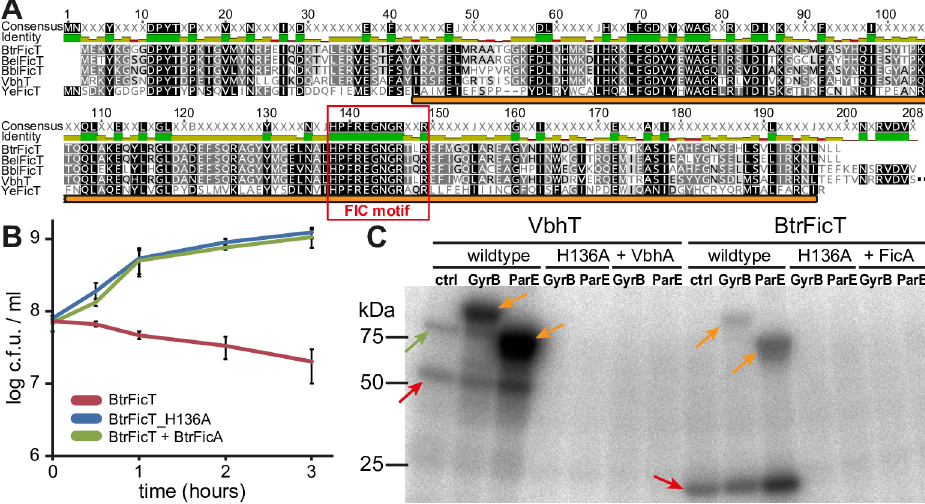
Fig 1. BtrFicTA is a regular FicTA module closely related to VbhTA. (A) Sequencealignment of YeFicT (UniProt identifierA1JNF3 (A1JNF3_YERE8)) and the FIC domainof VbhT (UniProt identifier E6Z0R3 (VBHT_BARSR)) with BtrFicT (UniParc identifier UPI00015FA8A2) and orthologsencodedby Bartonella elizabethae (BelFicT; UniParc identifier UPI00026E5C06)and Bartonellabirtlesii (BbiFicT; UniParcidentifier UPI00026E6E87). The FIC domaincore (interproIPR003812) is highlightedwith an orangebar. BtrFicT and its orthologshave > 70% identicalsequenceand share 60% sequenceidentity with the FIC domain of VbhT. The four proteins have 28% identicalsequencewith YeFicT. Note that all sequencesdisplaya canonical HPFX[D/E]GNGRXXR FIC signature motif (red frame), indicating AMPylation as their molecularactivity [34]. The coloringindicatesamino acid similarity accordingto the Blosum62score matrix with black = 100% identity and white = < 60% identity. (B) The colony forming units (c.f.u.) / ml of exponentially growing E . coli were recordedover time after the expressionof BtrFicT constructs had been inducedat t = 0 h with 2 mM of IPTG. Data points represent averageand standarddeviationof three independentexperiments. (C) Autoradiograph of an AMPylation assay with lysates of E . coli that had expresseddifferent VbhT or BtrFicT constructs. Reactionswere set up by adding[ α - 32 P]-ATP to trace AMPylation and lysates of E . coli that expressed GST- fusions of E . coli GyrB (DNA gyrase B subunit), E . coli ParE (topo IV B subunit), or a vector control. The autoradiograph shows VbhT and BtrFicT auto-AMPylation (red arrows), AMPylation of endogenous E . coli GyrB by VbhT (green arrow), and the AMPylation of ectopicallyexpressedGST-GyrB and GST-ParE for both constructs (orangearrows). Note that the “BtrFicT” construct includedexpressionof a marginalamount of BtrFicA which we determined to be necessary for the generationof solubleBtrFicT (see S1